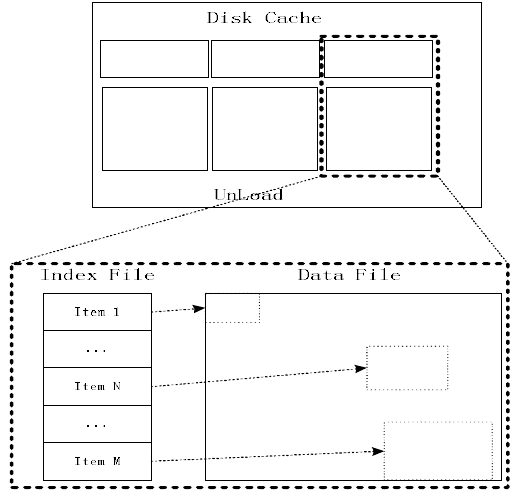
Figure 2. Data stored in disk cache